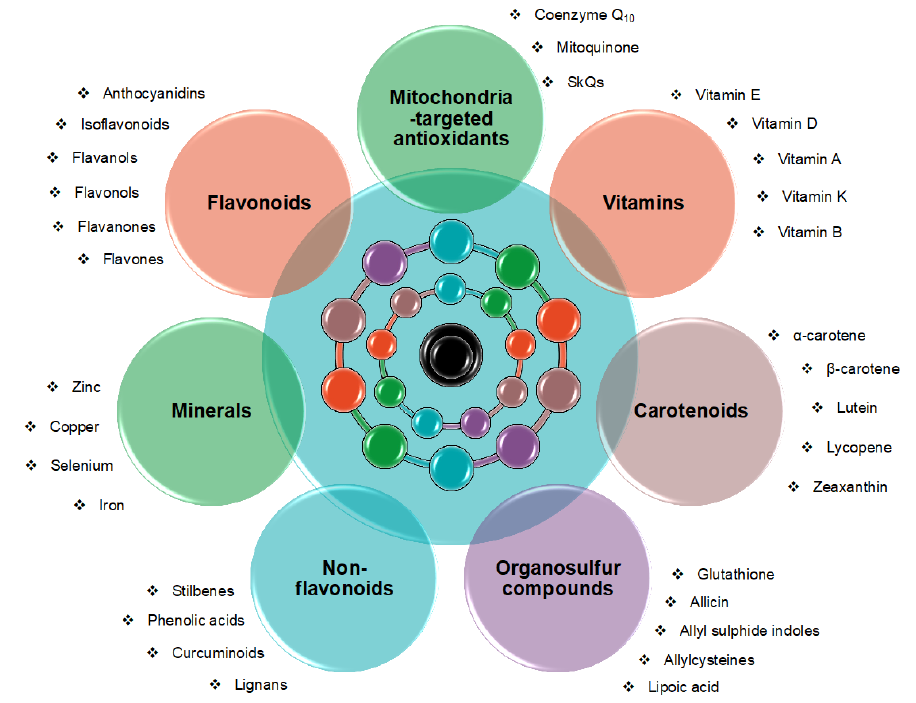
Figure 1. Antioxidant classification. The figure depicts the main classes of non-enzymatic antioxidants with potential diagnostic, preventative, and therapeutic applicability in the context of Alzheimer’s disease: mitochondria-targeted antioxidants, vitamins, carotenoids, organosulfur compounds, flavonoids, minerals, and non-flavonoids. The center depicts an iconic representation of a molecule with antioxidant properties.